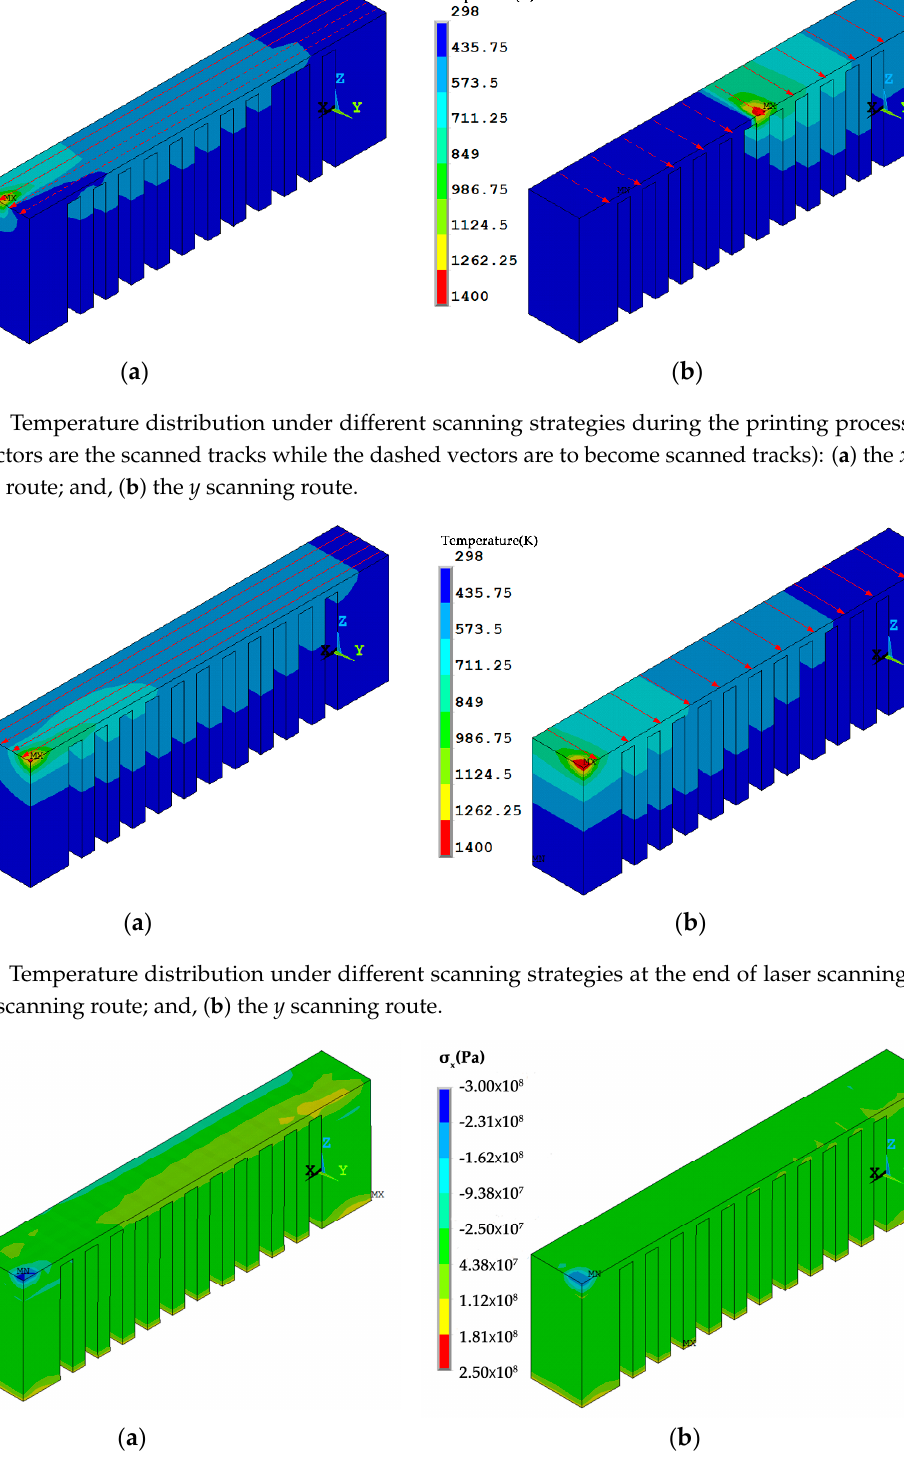
Figure 9. Residual stress σ x distribution of the specimens under different scanning strategies at the end of laser scanning: ( a ) the x scanning route; and, ( b ) the y scanning route.